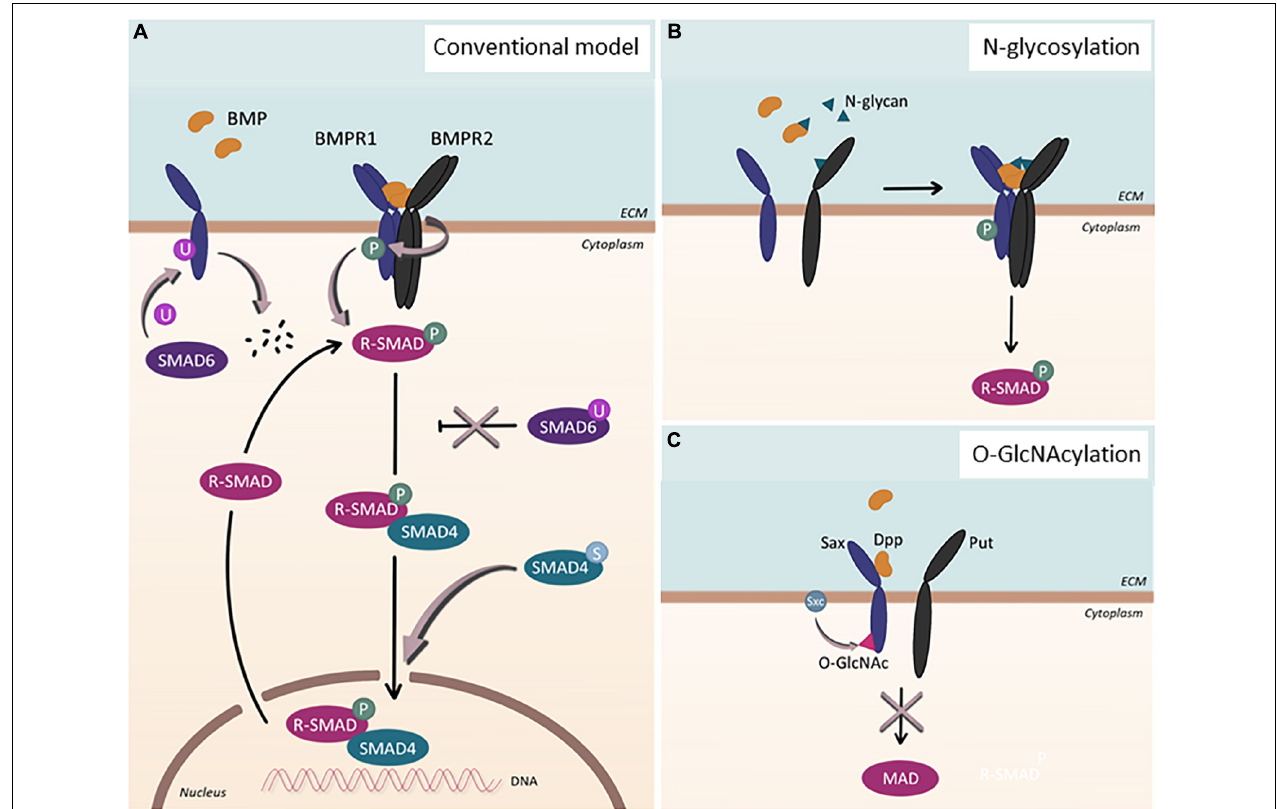
FIGURE 1 | Post-translational modification of BMP signaling components. (A) Conventional model of BMP signaling pathway. Upon BMP ligand binding, BMP type 1 receptor (BMPR1) is phosphorylated. Subsequently, R-SMADs, SMAD1/5/8, become phosphorylated and, together with SMAD4, localize into the nucleus to regulate gene transcription. This process can be inhibited by SMAD6. Additional post-translational modifications affect the signaling pathway in various ways: SMAD6 can regulate BMPR1 by facilitating its ubiquitination and subsequent degradation. Upon ubiquitination of SMAD6, SMAD6 loses its ability to inhibit the BMP signaling cascade, which ultimately leads to upregulation of the signaling pathway. When SMAD4 undergoes sumoylation, nuclear accumulation of the protein is enhanced. (B) N-glycosylation. N-glycans can bind to BMP ligands as well as to BMP type 2 receptors (BMPR2), enabling proper folding and binding of the proteins. (C) O-GlcNAcylation. In Drosophila , Sxc facilitates O-GlcNAcylation of Sax, the ortholog for human ALK2, resulting in the attenuation of the signaling